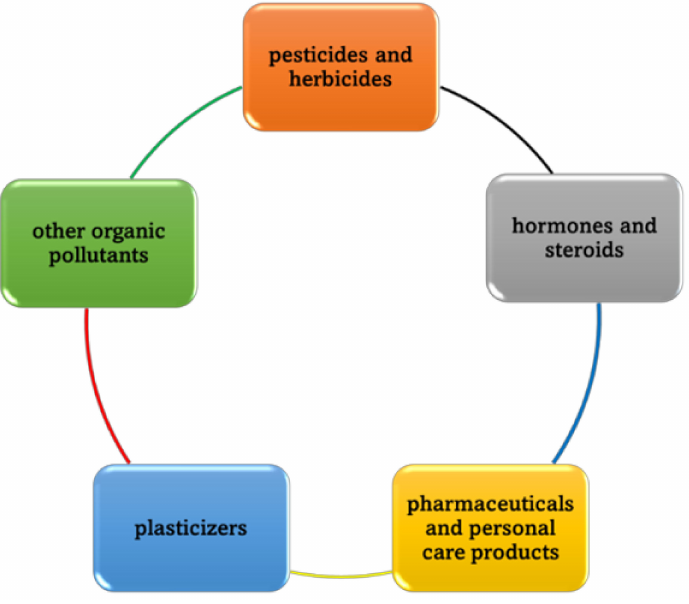
Figure 2. Classification of